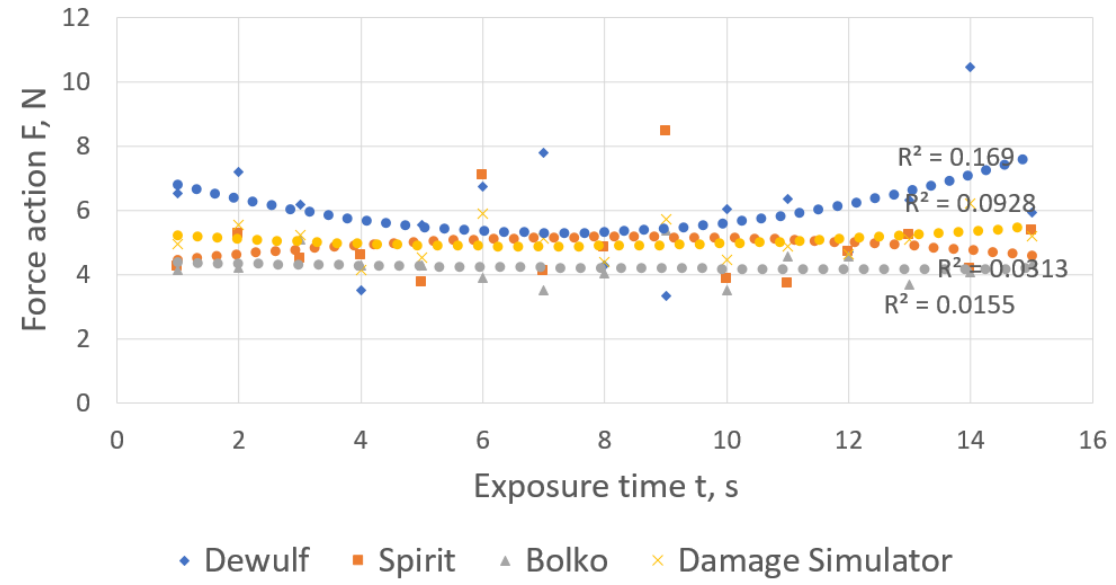
Figure 6. Force action of the work surface of the pin hummock on potato tuber.